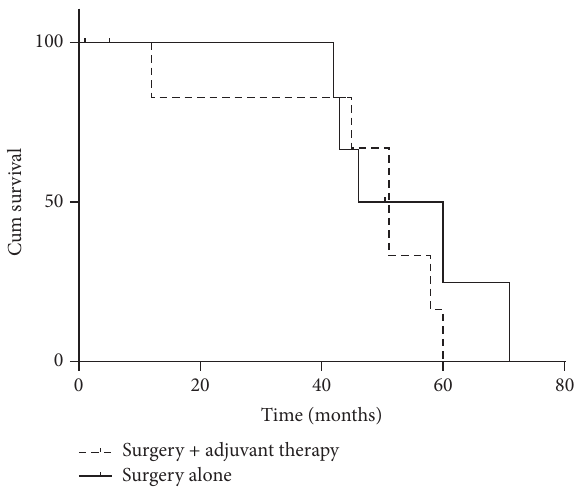
Figure 3: Survival curves of surgery alone group and surgery plus adjuvant therapy